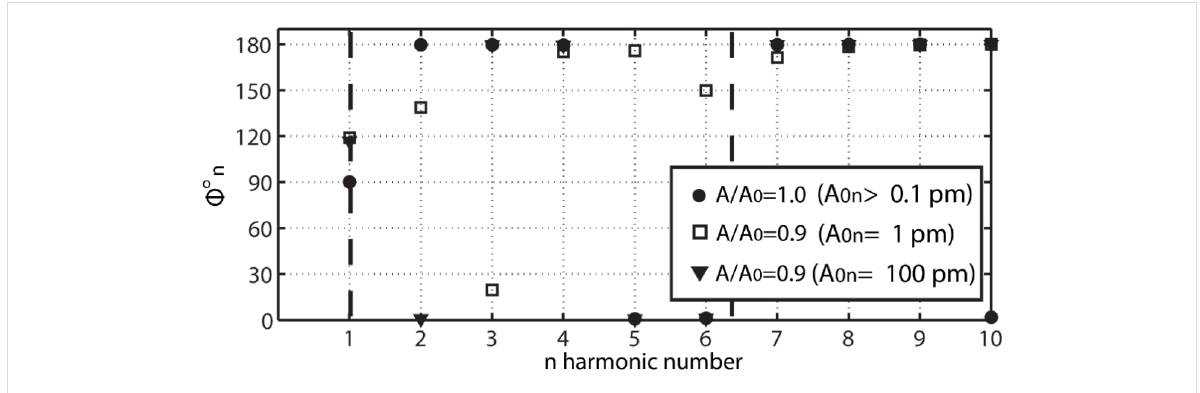
Figure 1: Phase shifts of higher harmonics, including the fundamental shift , when N = 10 external harmonic drives are introduced. The values are shown for a free oscillating cantilever (circles). For the free cantilever the separation is z c >> A / A 0 = 1. Then the cantilever is gently interacting (peak forces smaller than 20 0pN) with the surface, i.e., A / A 0 < 1, while the free higher harmonic amplitudes A 0 n are set to 1 (squares) and 100 (trian- gles) pm.